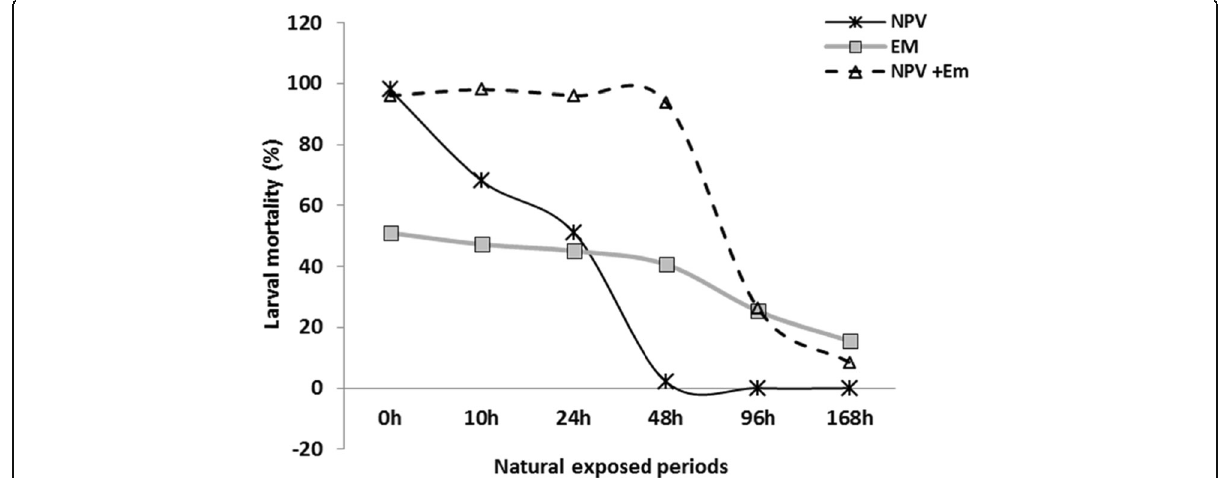
Fig. 4 Average rates of reduction in the spli NPV activity expressed in mortality percentages of Spodoptera littoralis 2nd larvae treated with Spli MNPV, Em, and Em LC 50 + Spli MNPV Lc 99 , all exposed to different natural sunlight periods